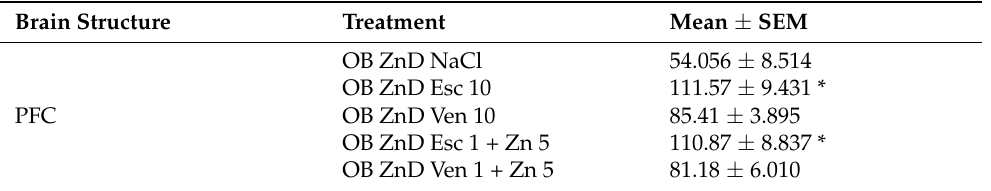
Table 3. The effects of antidepressants and Zn supplementation on intracellular zinc concentration in rats subjected to the OB + ZnD model using fluorescent Zinpyr-1